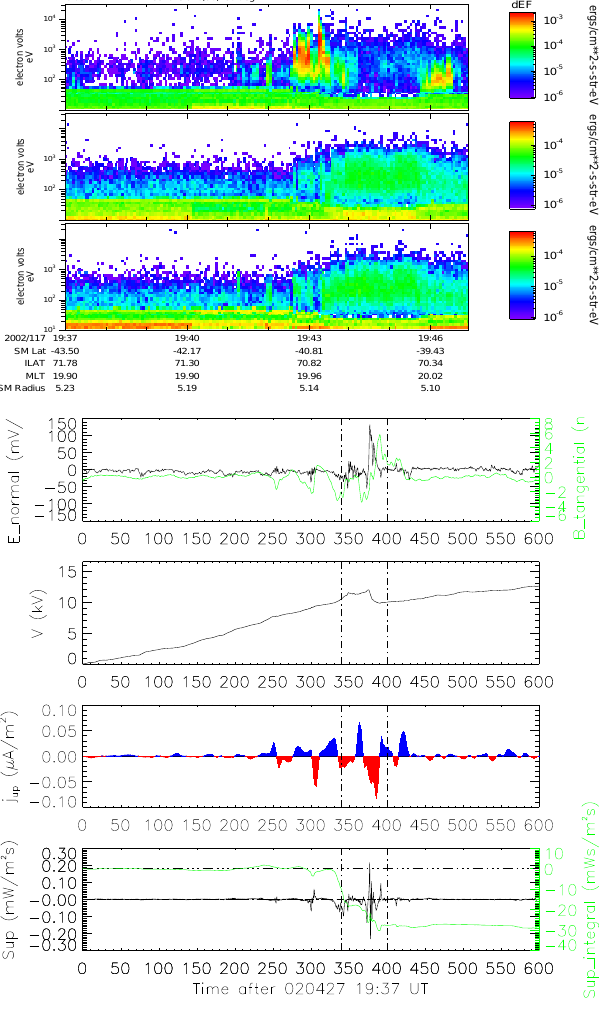
Fig. 8. 27 April 2002, s/c 4. The same panels as in Fig. 2.